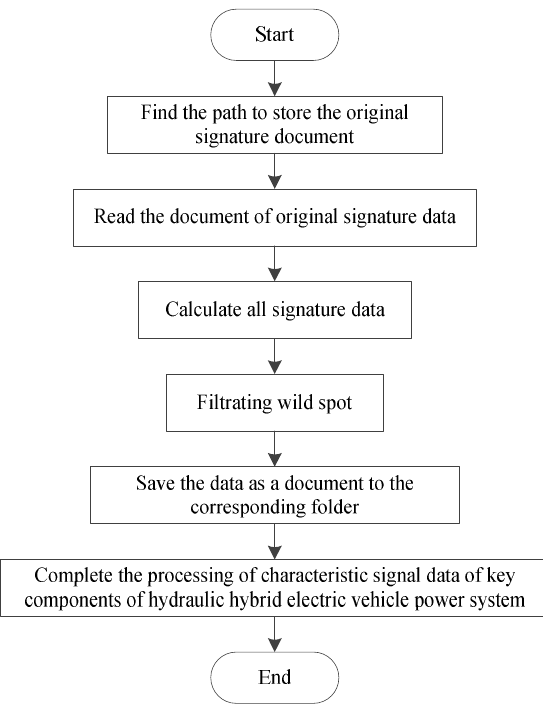
Figure 3. Processing flow for characteristic signal data.